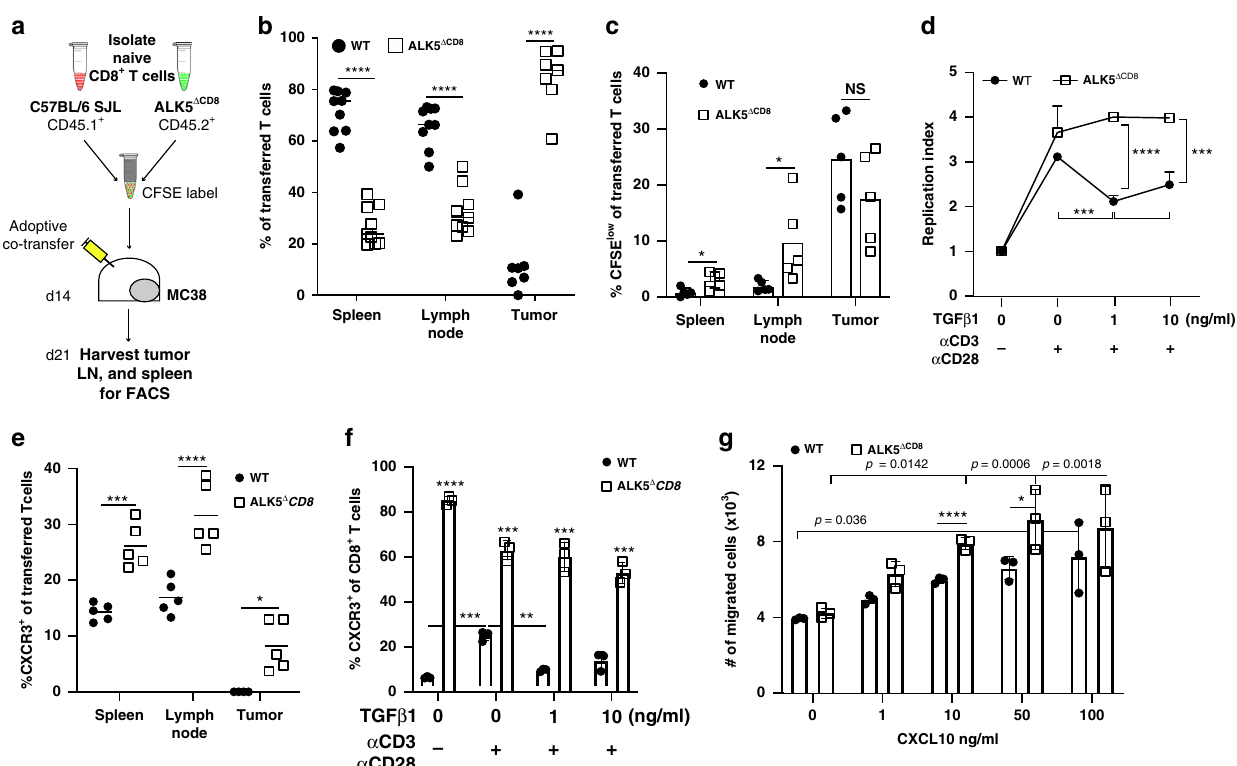
Fig. 4 ALK5 Δ CD8 T cells upregulate CXCR3 and preferentially migrate to the tumor. a Experimental schema for adoptive co-transfer of congenic C57BL/ 6 WT and ALK5 Δ CD8 CD8 + T cells into MC38 tumor-bearing mice. b The frequency of transferred CD45.1 WT and CD45.2 ALK5 Δ CD8 CD8 + T cells ( n = 9 recipients) analyzed in the spleen, lymph node, and tumor; each symbol represents one mouse, measure of center = mean, CD45.1 WT transferred T cells (black circles) and CD45.2 ALK5 Δ CD8 transferred T cells (white boxes). Shown is a compilation of two independent experiments. **** p < 0.000001. c